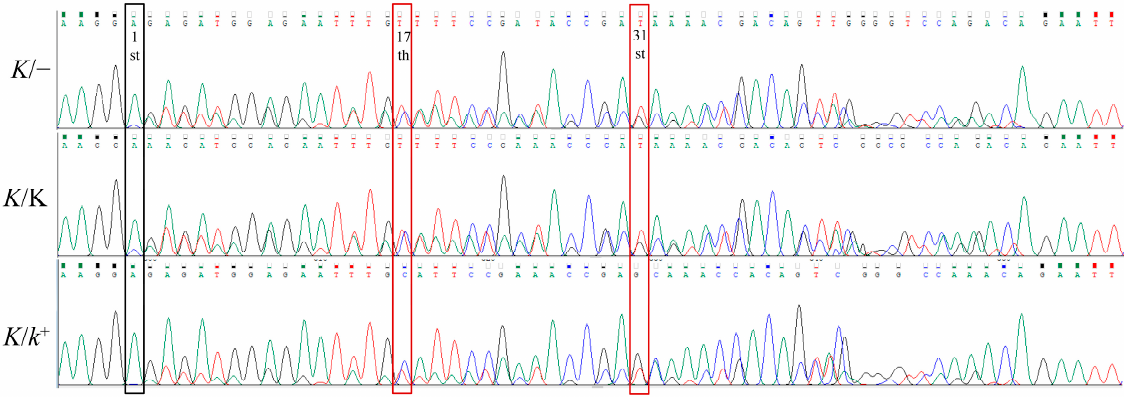
Figure 3. The part of the Sequencing peak of LF by Sanger sequencing with R primers. After passing the breakpoint, there is a section of double peaks in LF. The first doublet peak after the breakpoint is counted as the 1st, and the peaks of the 17th and 31st positions always show obvious changes in LF female, LF homozygote, and heterozygote. These two positions could be taken as two molecular markers for homozygote and heterozygote identification.